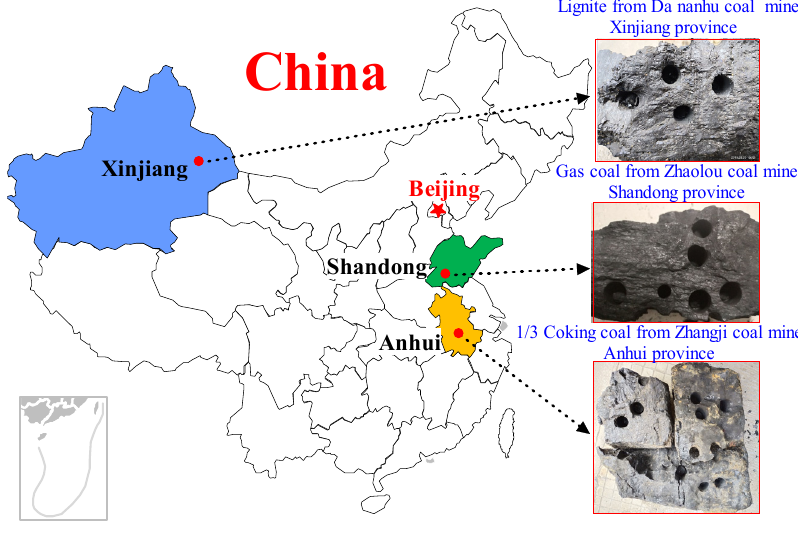
Figure 2. Geographic location and preparation of the three coal cores in this study.